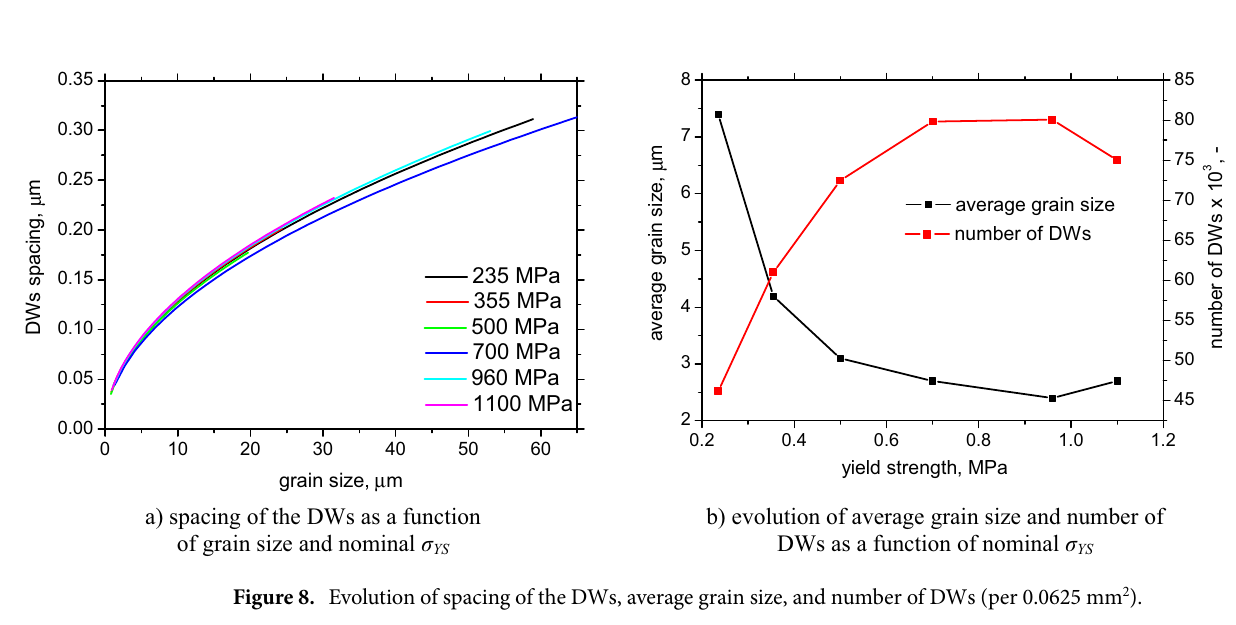
Figure 8. Evolution of spacing of the DWs, average grain size, and number of DWs (per 0.0625 mm 2